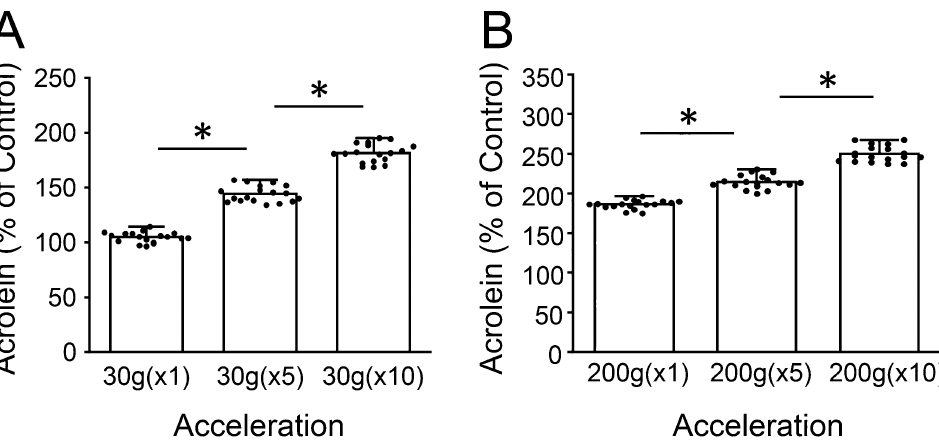
Figure 4. Elevation of acrolein-Lys adducts as a function of repeated impacts. Average intensity measurements for multiple impacts of 30 ( A ) and 200 g ( B ) rapidly (4–6 s) administered five and ten times. A single impact at both g forces levels is included for comparison. The increasing values displayed for both 30 and 200 g represent a cumulative effect of rapid, multiple impacts (note the difference in y-scale). Staining intensity is shown as percent control values ± SD (n = 18). One-way ANOVA and subsequent Scheffe post hoc analysis were used to determine significance: *p < 0.01.